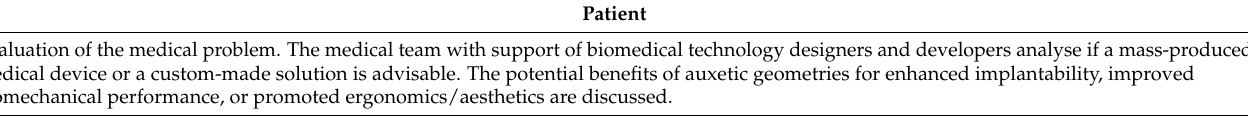
Table 1. Schematic summary of development workflow for biomedical